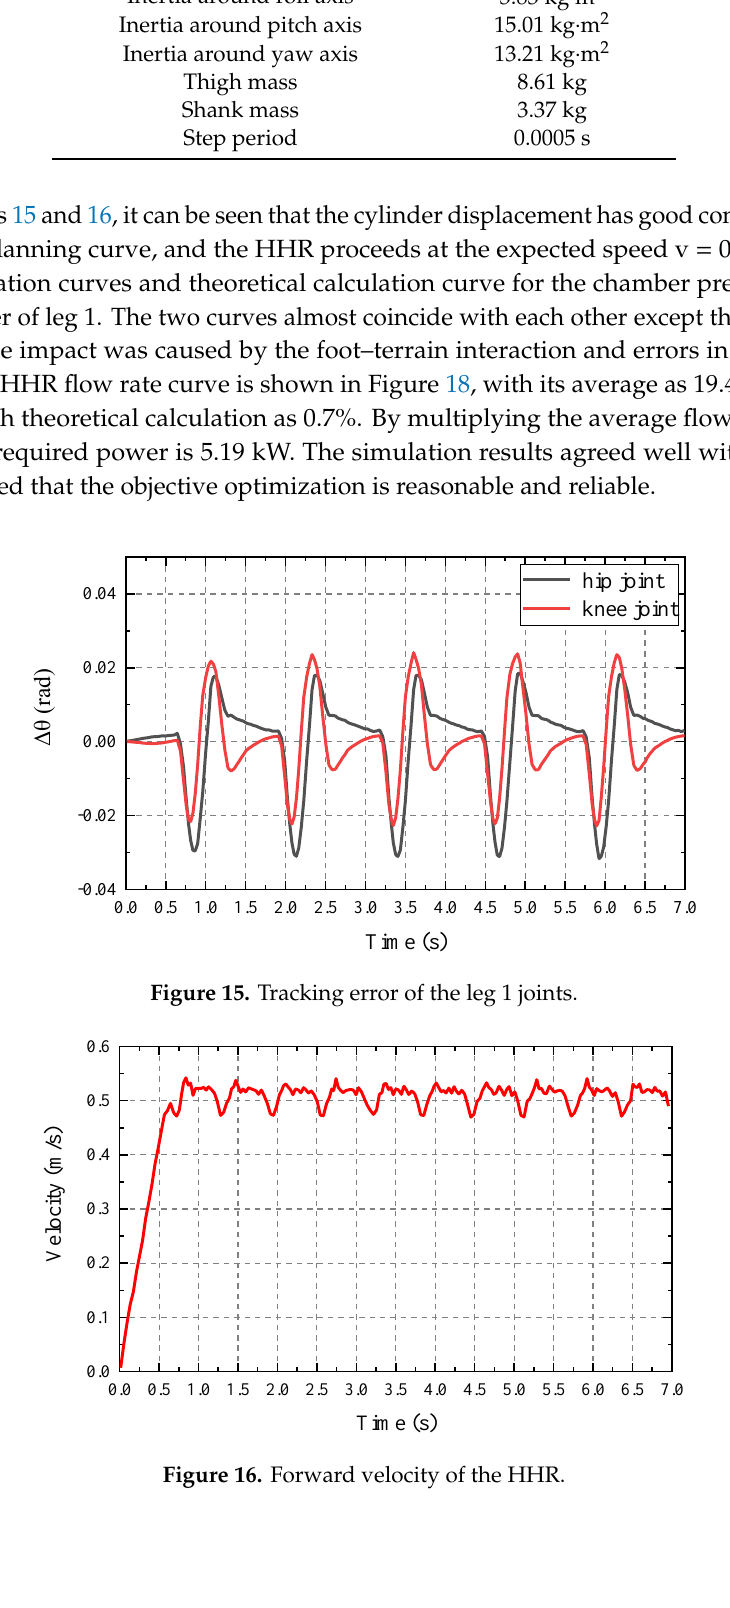
Table 7. The simulation parameters of robot in ADAMS.